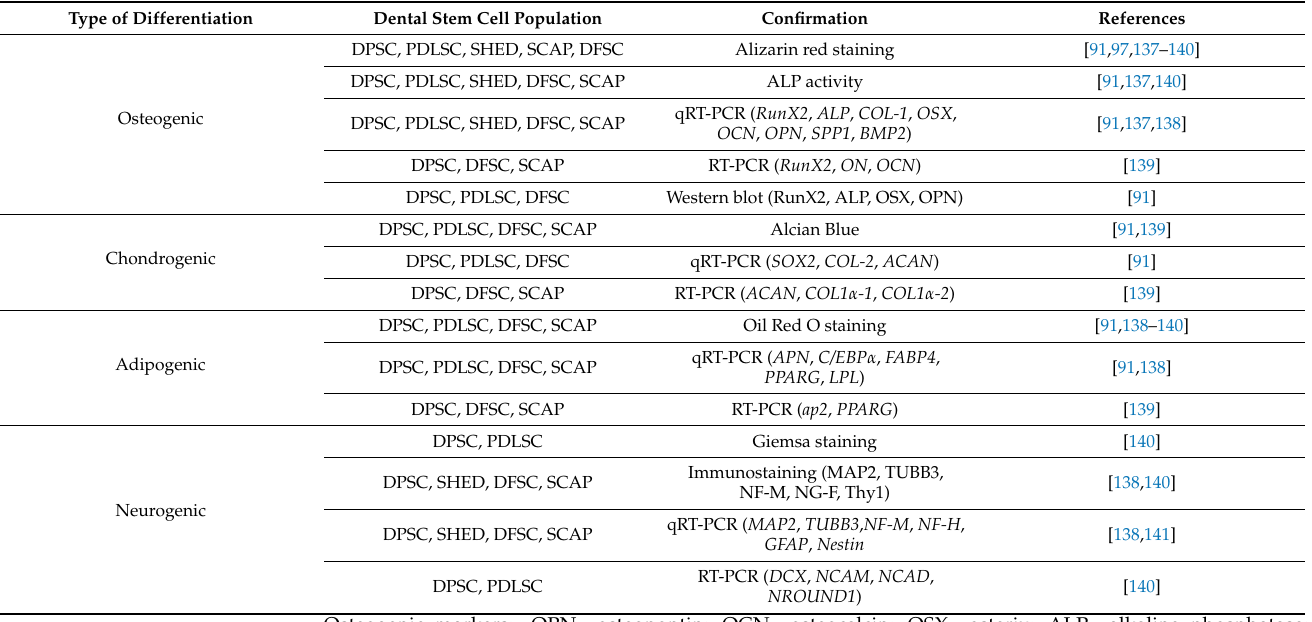
Table 2. Published results on the multilineage differentiation potential of several DMSC